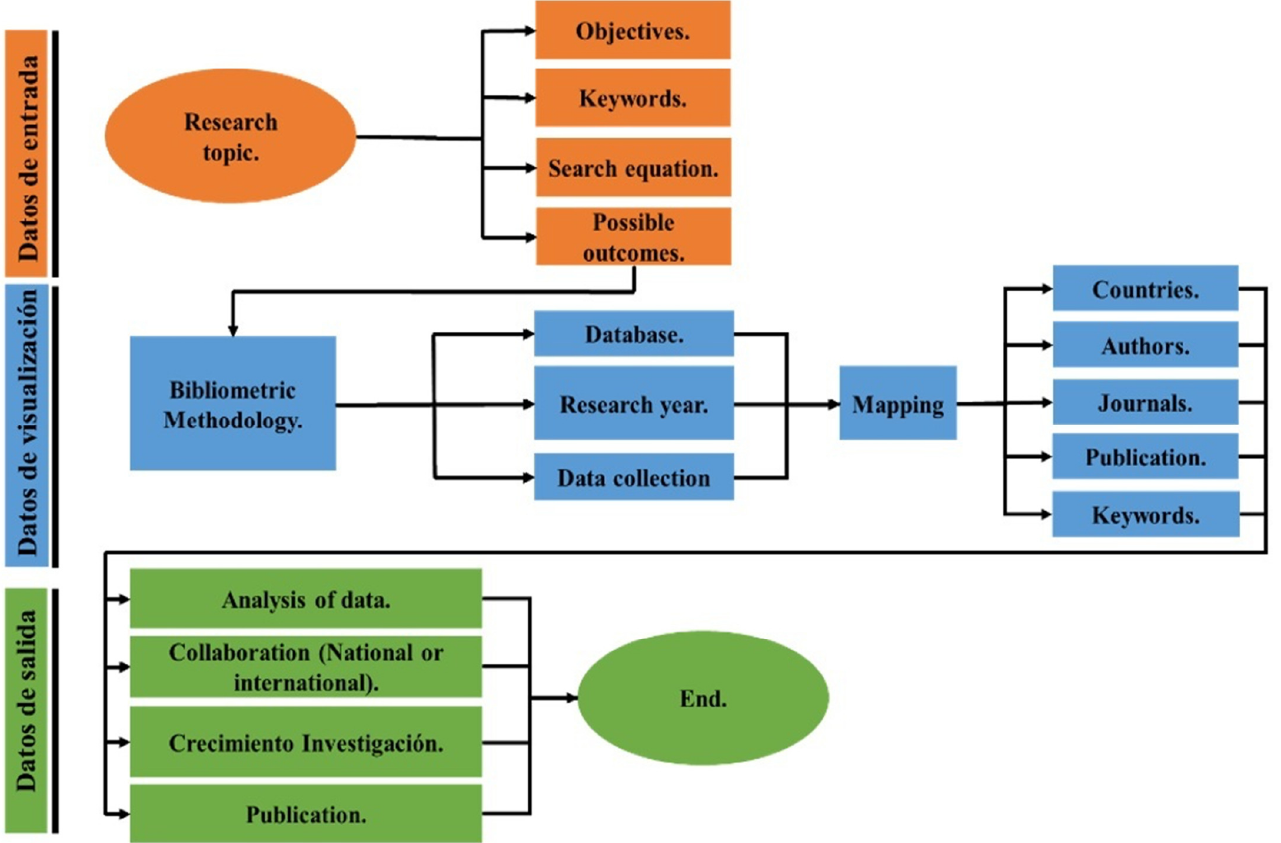
Figure 1. Bibliometric methodology.